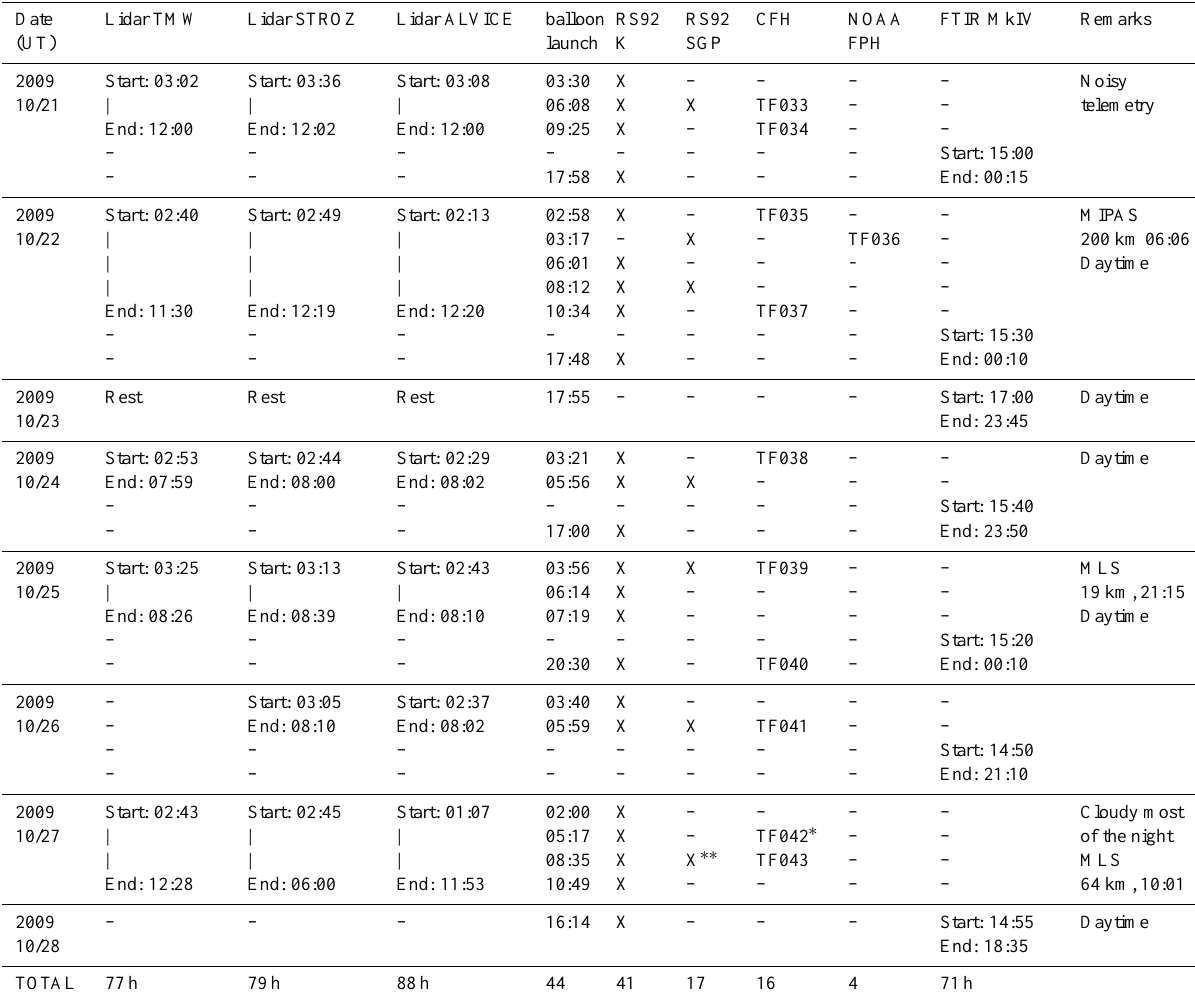
Table 2b. Summary of MOHAVE-2009 operations (21–28